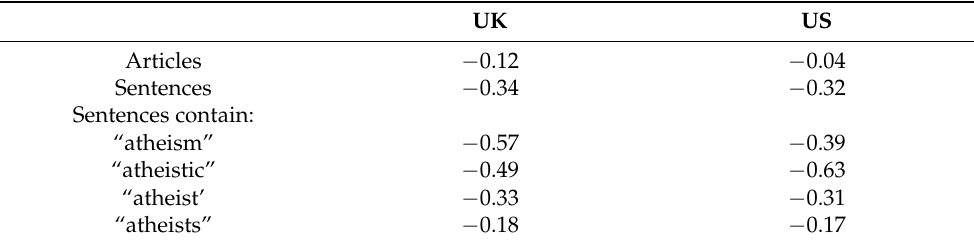
Table 3. Sentiment analysis: the average tone of texts referencing atheism or atheists.